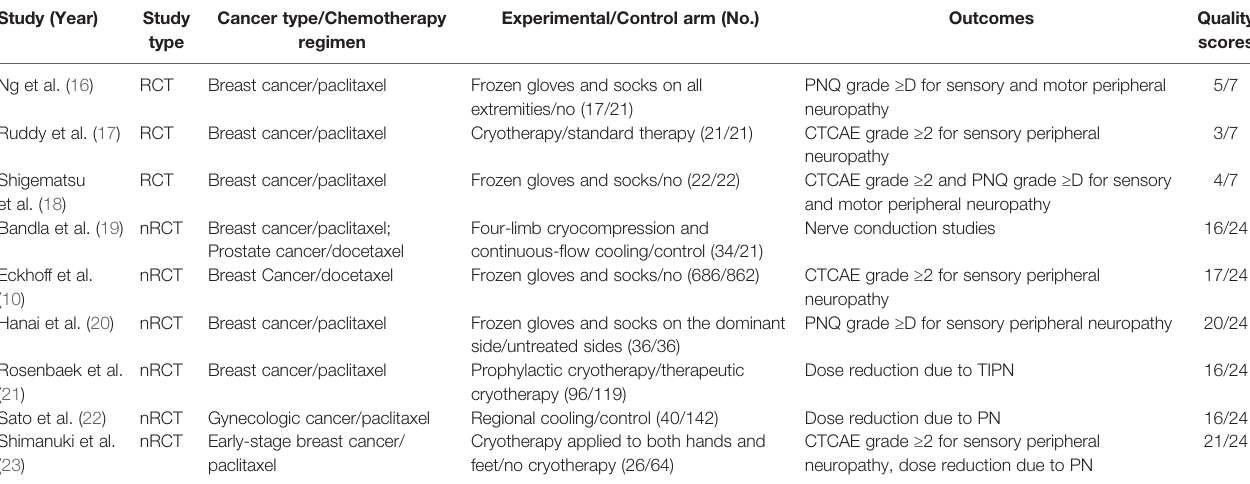
TABLE 1 | Characteristics of the included